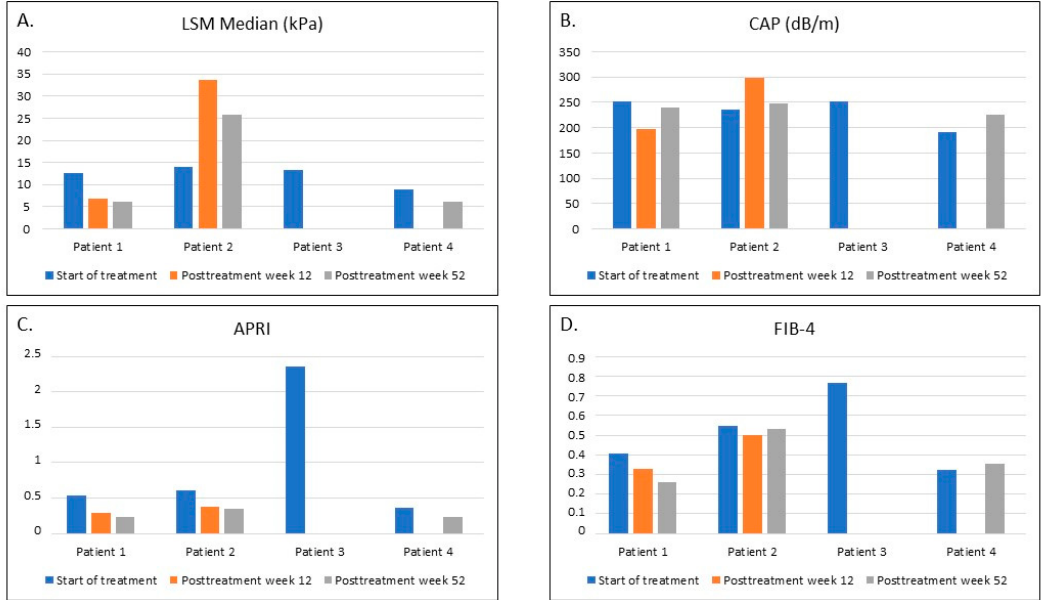
Figure 1. Noninvasive evaluation of liver fibrosis and steatosis in four patients with significant fibrosis at baseline, treated with ledipasvir/sofosbuvir: at the start of treatment, at week 12, and week 52 posttreatment. ( A ). Liver stiffness measurement (LSM) median. ( B ). Controlled attenuation parameter (CAP) ( C ). Aspartate transaminase-to-platelet ratio index (APRI) ( D ). Fibrosis-4 index